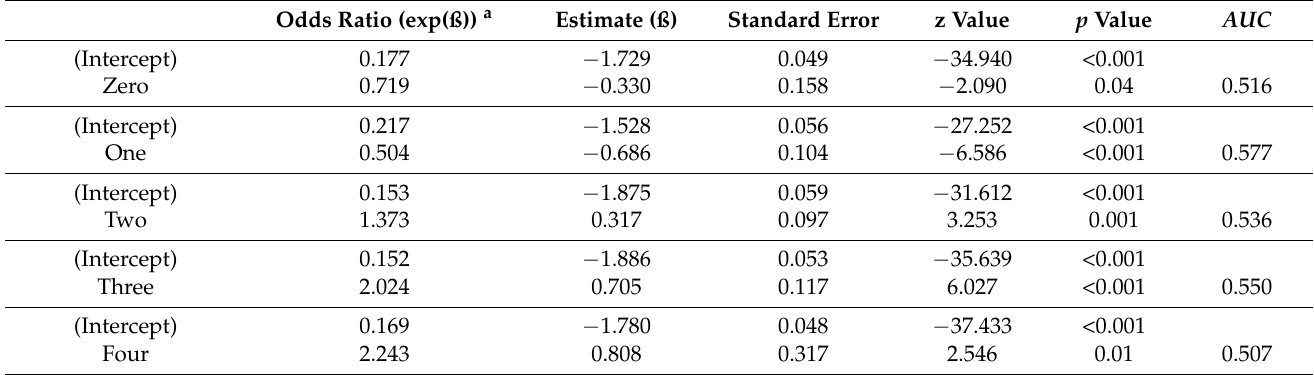
Table 6. Results from univariate logistic regression analyses with the number of guiding principles used as the predictor variable for the level of tweet